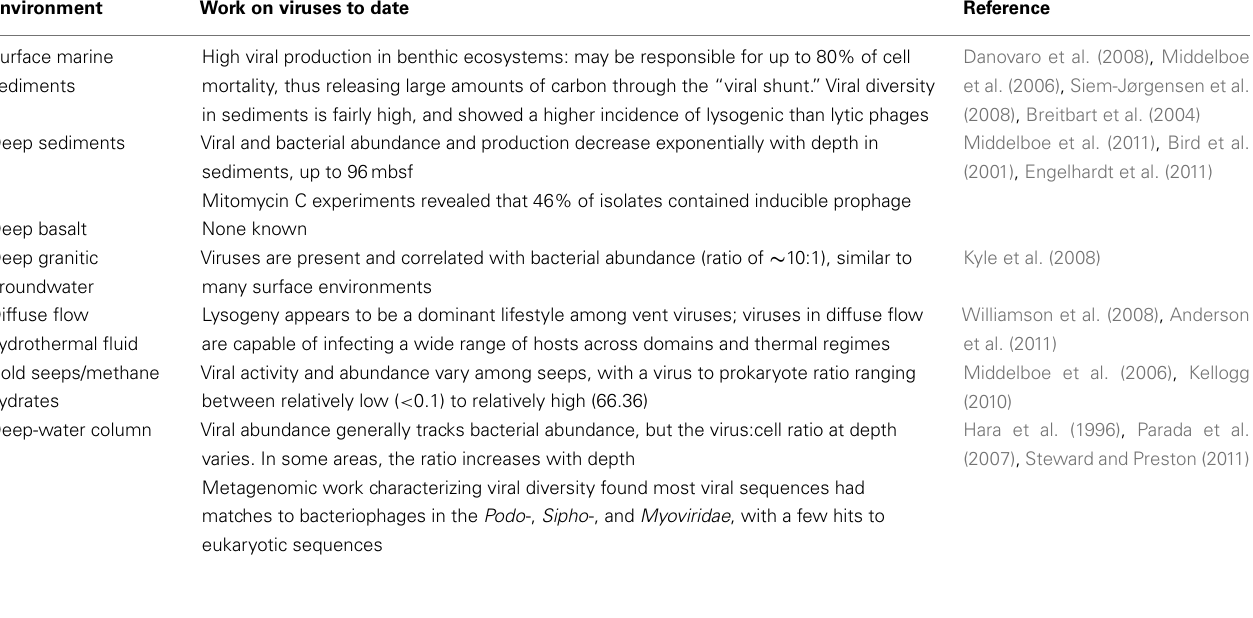
Table 1 | Summary of previous work on viral abundance, activity, and diversity in various environments of the deep subsurface biosphere, deep ocean, and